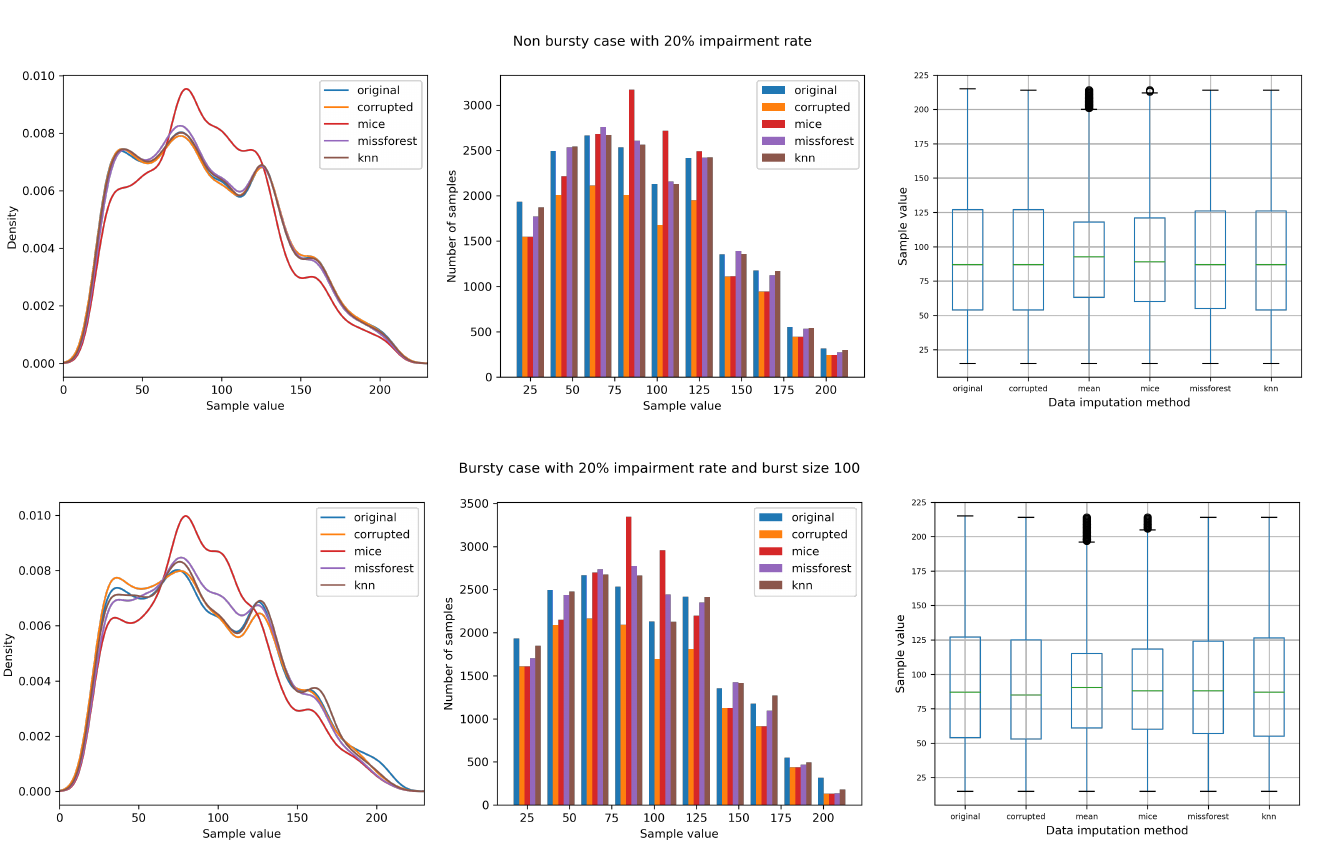
Figure 4. Non-bursty case and bursty case for the same impairment rate (20%).